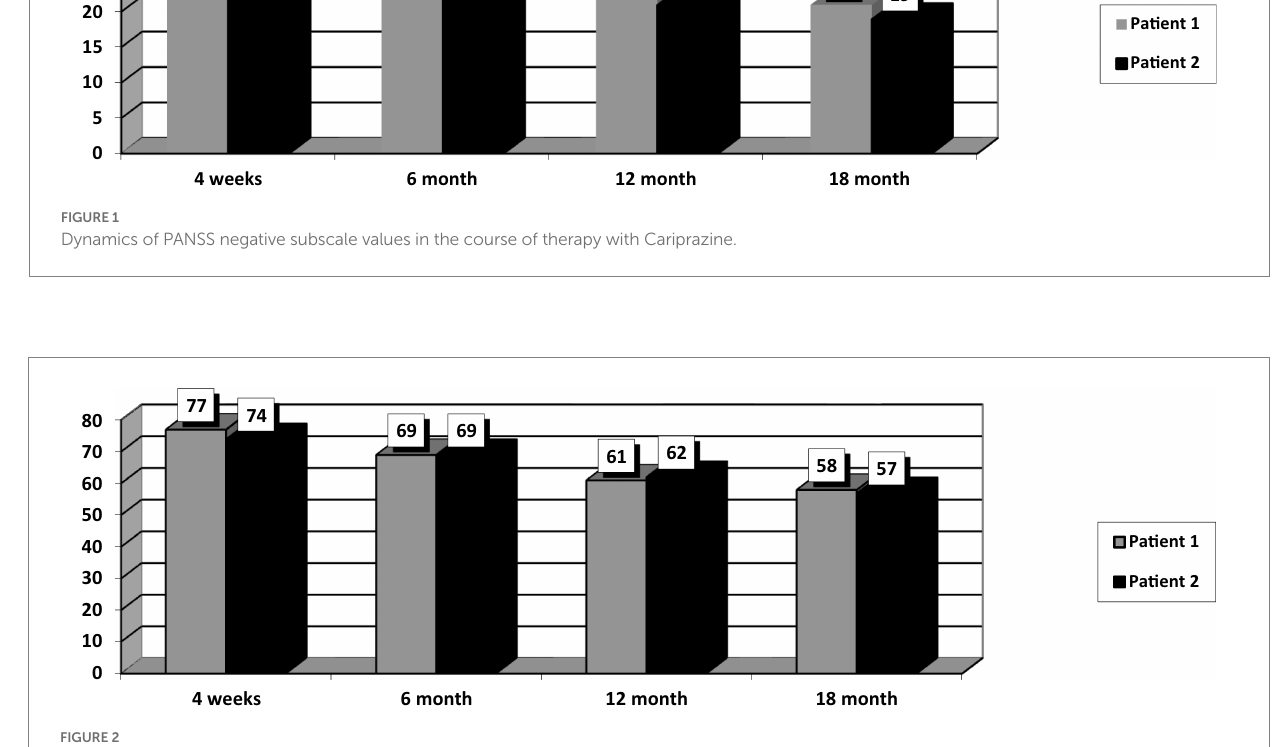
FIGURE 2 Dynamics of the overall PANSS mean score in the course of therapy with Cariprazine.